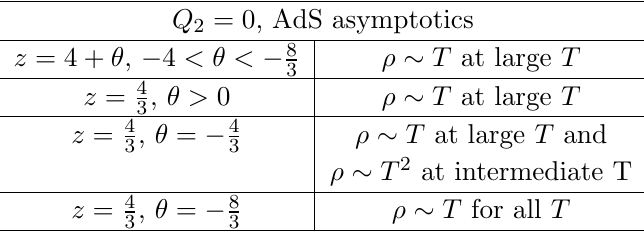
Table 1 . Single charge case, AdS asymptotics . A few representative cases (examined in 5.1),